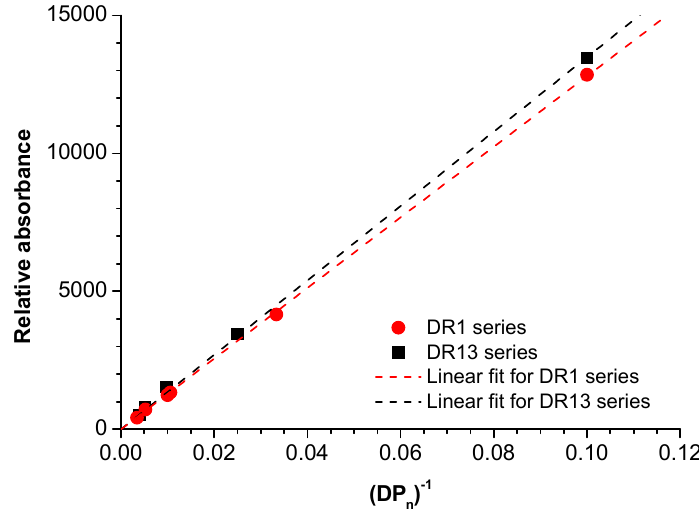
Figure 9. Relative absorbance of the PLA-n-DR at 470 nm versus inverse DP n for DR1 (red circles) and DR13 (black squares) series; points are experimental data, whereas dashed lines are linear fits for that